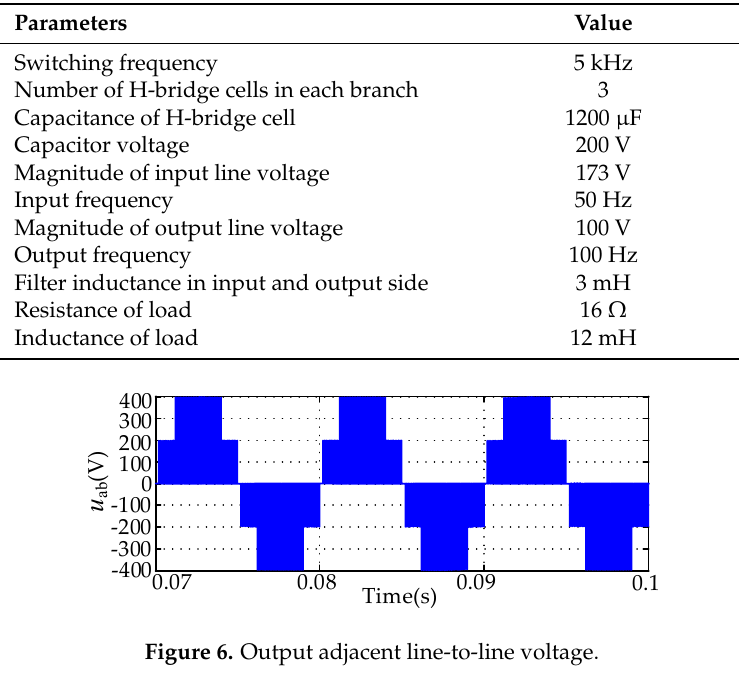
Table 3. Simulation parameters.